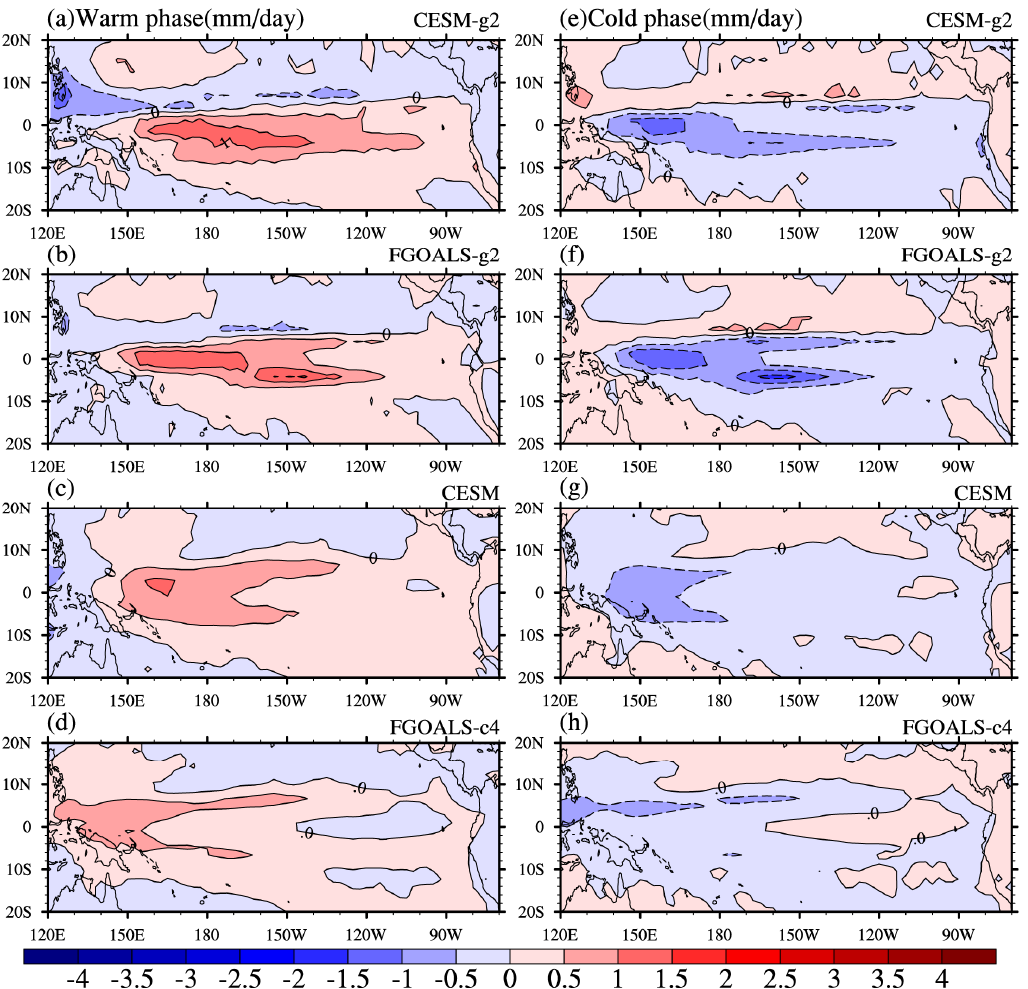
Figure 6. Spatial patterns of averaged composite anomalies of the warm phase (Left) and cold phase (Right) for stratiform precipitation from the four cross-coupled parent models: ( a , e ) CESM-g2, ( b , f ) FGOALS-g2, ( c , g ) CESM, ( d , h ) FGOALS-c4.